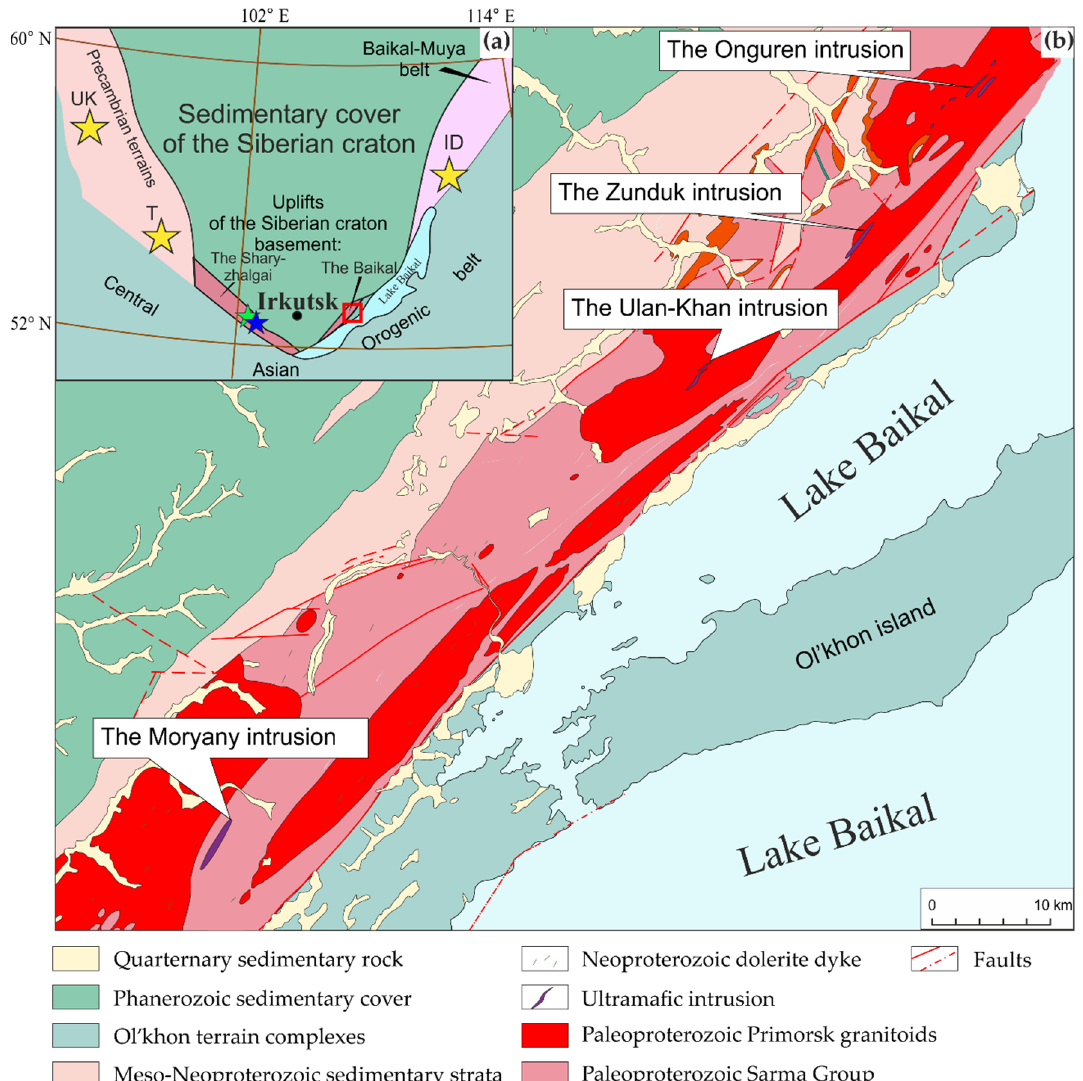
Figure 1. ( a ) Sketch of the tectonic map of southern Siberia and the location of the region where the studied ultramafic intrusions are located (red square). Stars indicate the locations of the Precambrian mafic-ultramafic intrusions: yellow—Neoproterozoic (UK—Upper Kingash, T—Tartay, Medek, etc., ID—Ioko-Dovyren), blue—Mesoproterozoic (Srednecheremshanka), green—Paleoproterozoic (Malyi Zadoi); ( b ) Simplified geological map of the southwestern part of the Akitkan orogenic belt and adjacent areas.